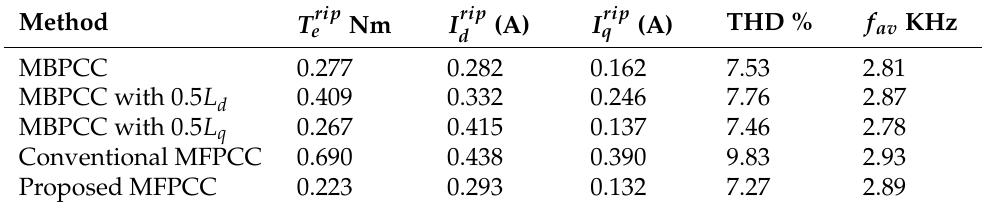
Table 2. Comparison of proposed approach with different methods.